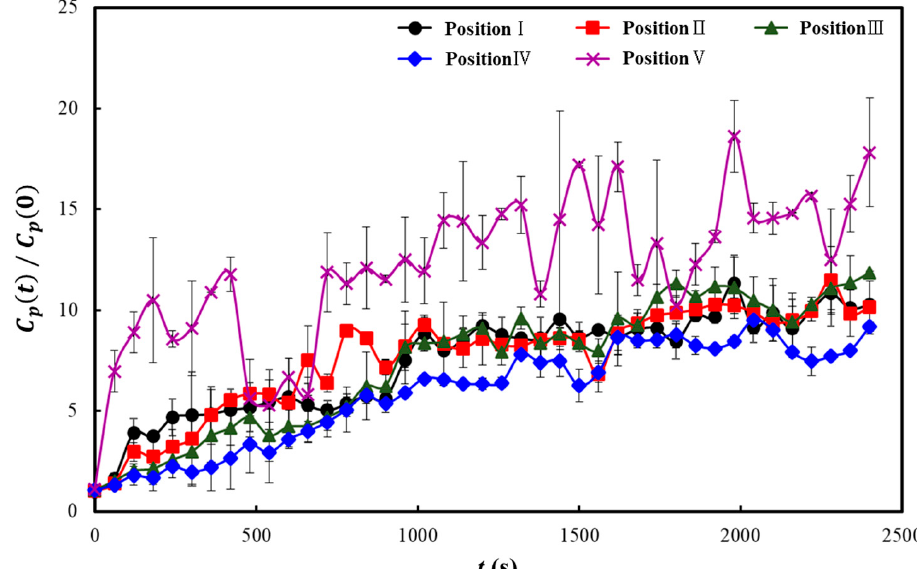
Figure 5. Dimensionless particle number concentrations at measurement positions I to V (the positions are shown in Figure 1c) in the closed condition when only the heater was operated (Case 1), where C p ( t )/ C p (0) represents the dimensionless particle number concentration obtained by dividing the particle number concentration over time ( C p ( t )) by the initial particle number concentration ( C p (0)).